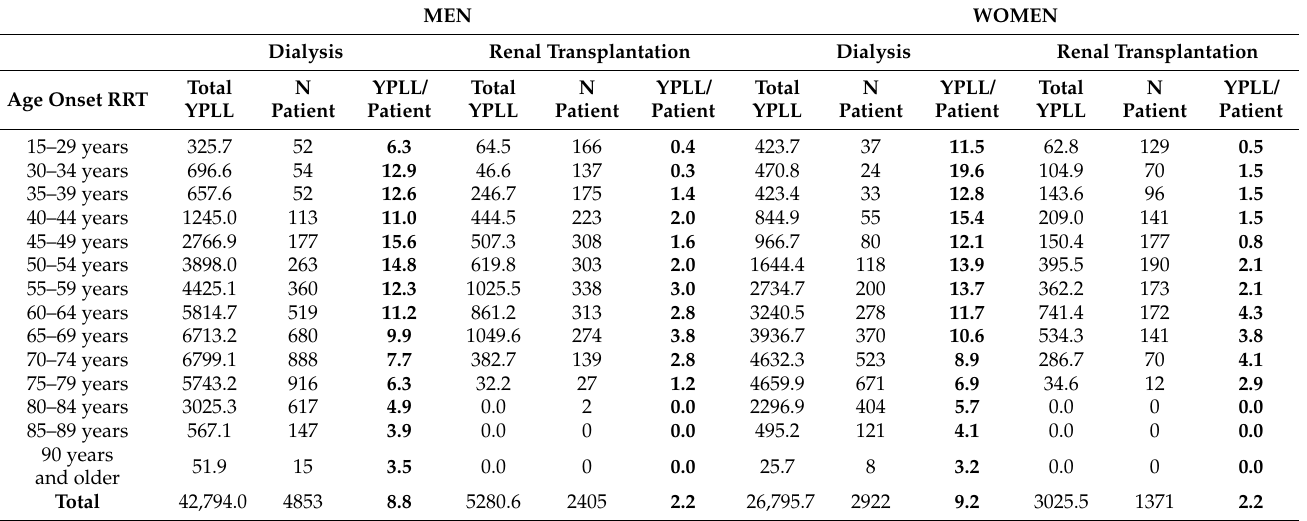
Table 3. Years of potential life lost in men and women according to age of onset of dialysis or renal